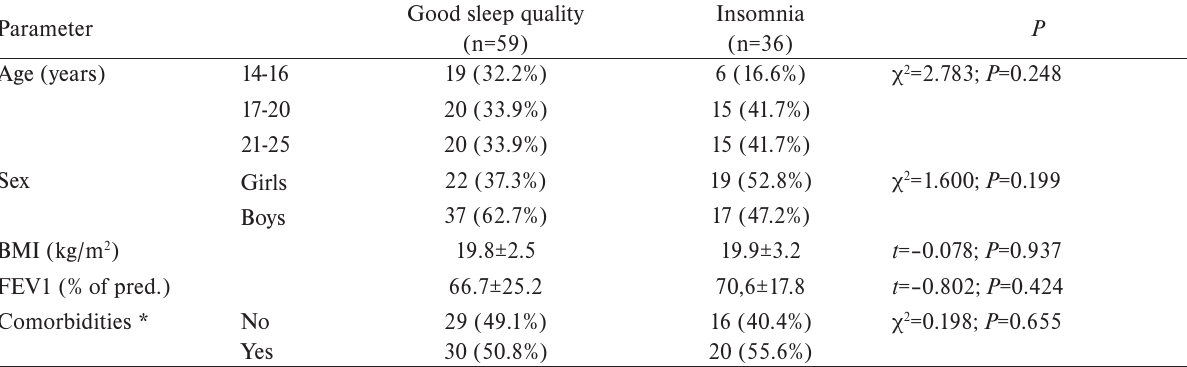
Table 1. Comparison of patients in terms of demographic and clinical characteristics.